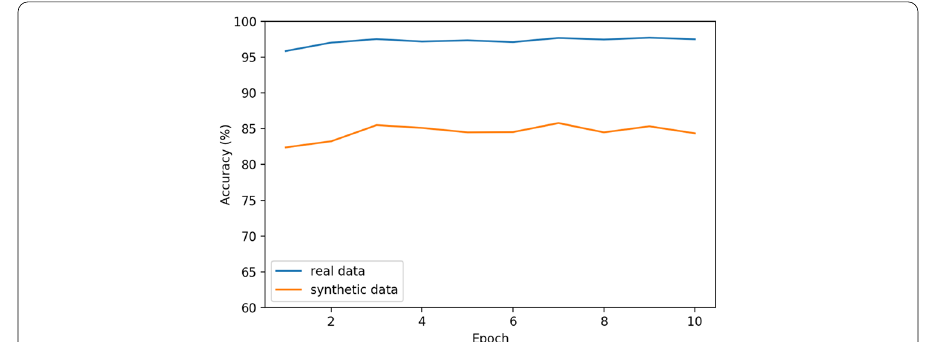
Fig. 2 Test accuracy of the model using real training data vs synthetic training data over 10